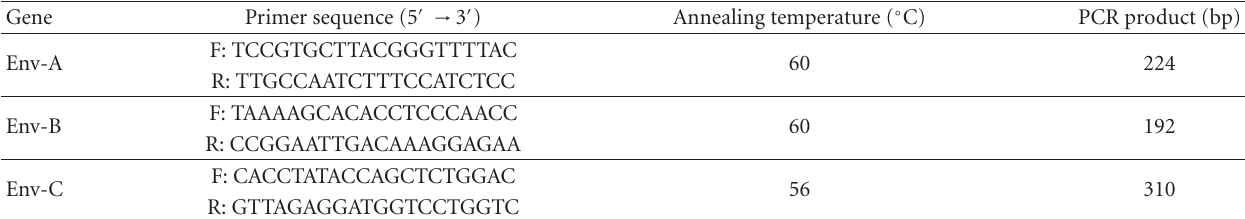
Table 1: Type-specific primers for screening PERV-positive clones from NIH miniature pig BAC library. Gene Primer sequence (5 (cid:3) → 3 (cid:3)